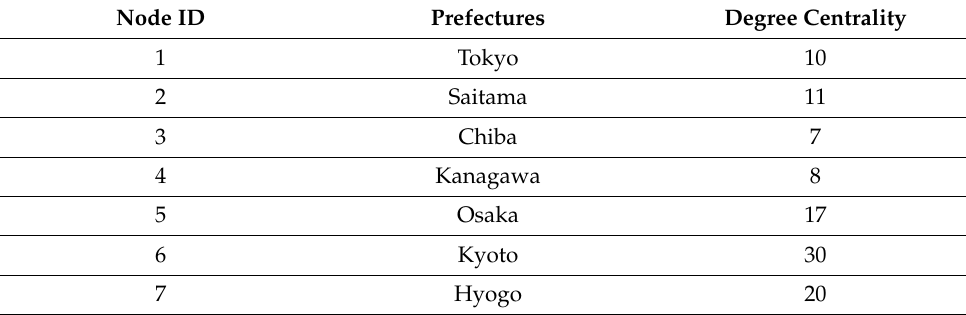
Table 4. Degree centrality of prefectures in